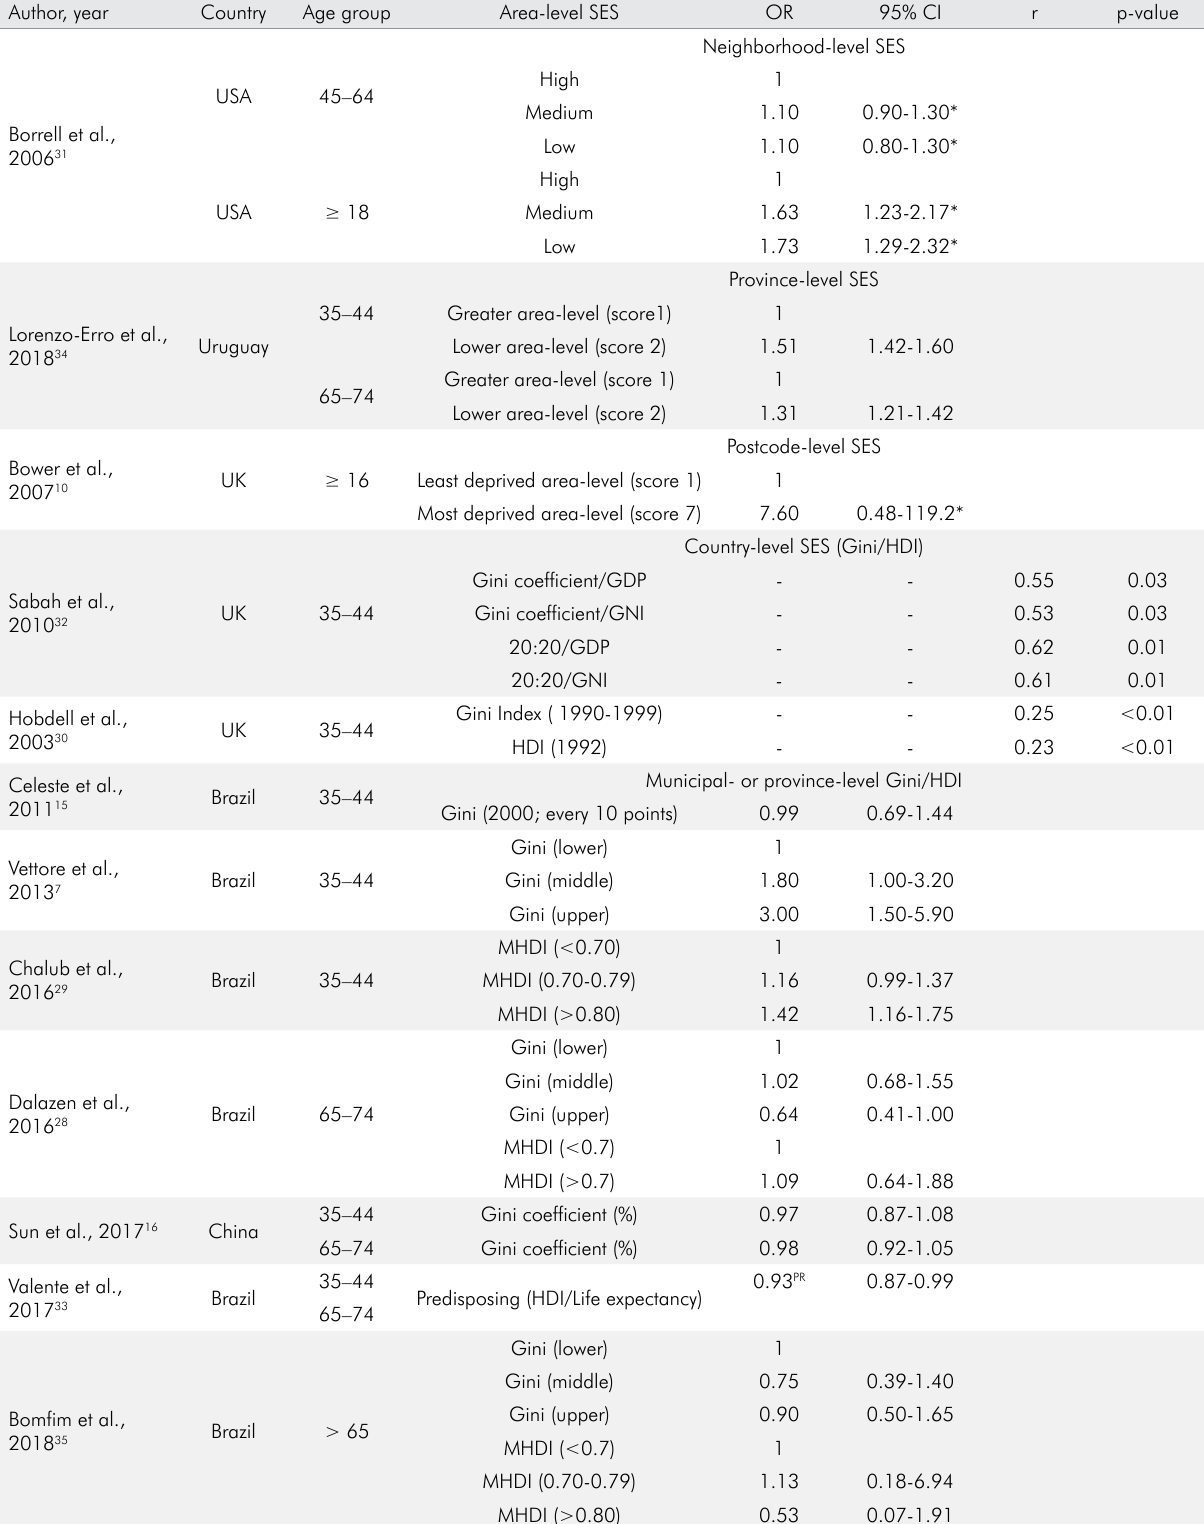
Table 3. Main outcomes [pooled odds ratio (OR) and confidence interval (95%CI)] for studies assessing the association between area SES-level and